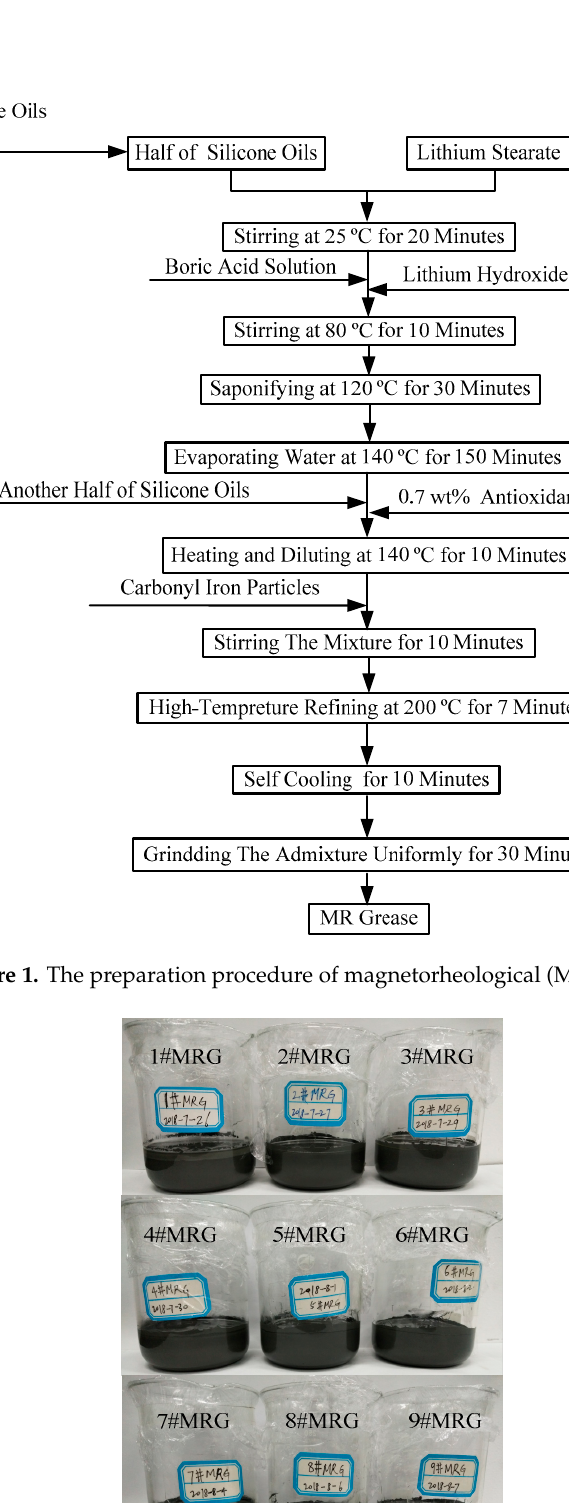
Figure 3. Calculation of dynamic yield stress of MR grease at zero shear rate 3. Results and Discussions Based on the L 9 orthogonal array test program, nine MR grease samples were successively tested and each response parameter result was obtained under each condition of input parameters (each corresponding row), as shown in Table 2 and Table 3. Table 2 and Table 3 show that the field-dependent dynamic yield stress for each MR grease sample increased with increasing magnetic field strength. This phenomenon is related to the stronger dipole–dipole interaction between CIPs through the increment of magnetic field strength [8,11]. In the absence of a magnetic field, the dynamic yield stress ranged from 0.215 to 2.506 kPa for all the samples due to the viscoplasticity of the grease medium. The yield stress varied from 26.86 to 65.96 kPa for all MR greases at the maximum magnetic field strength of 0.7041 T. Of all the samples, the eighth MR grease (8#MRG) produced the highest yield stress of 65.96 kPa at the magnetic field strength of 0.7041 T under the input parameter conditions of CIPs fraction—75 wt%, SOV—500 m 2 ·s − 1 , CIP size—3.2 μ m. This high field-induced yield stress suggested that more stable magnetic particle chain structures were formed at high magnetic field strengths [18]. 3.1. Qualitative Significance Evaluation of SOV, CIPs Fraction, and CIP Size towards Yield Stress The analysis of variance (ANOVA) was conducted from the data of Table 2 and Table 3, and the statistical results were obtained, as shown in Table 4, by using MINITAB17 statistical software. The